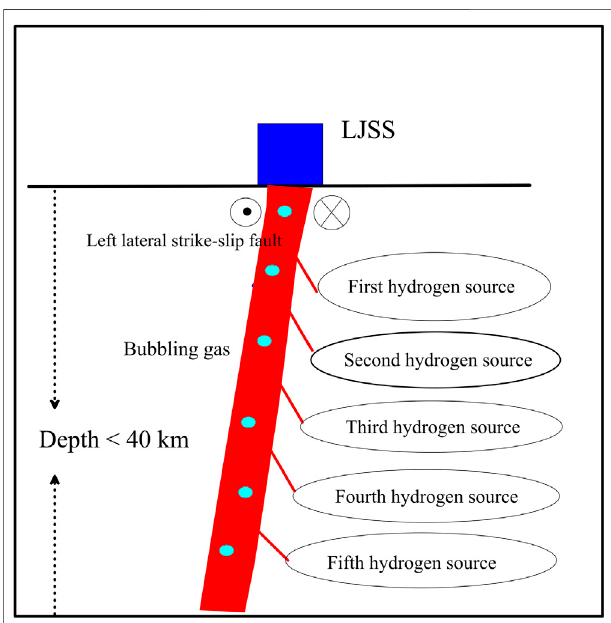
FIGURE 11 | Schematic diagram of hydrogen sources in Luojishan hot spring bubbling